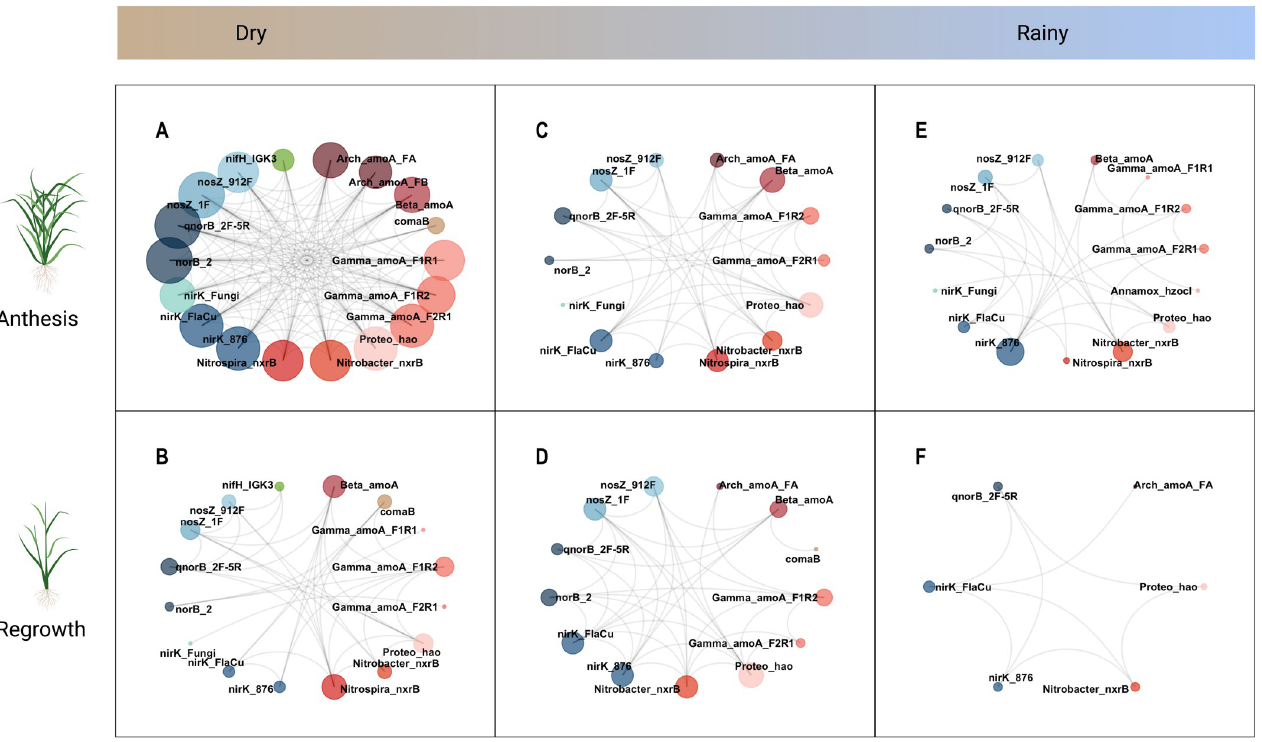
Fig 4. Non-directed intersection networks of N-cycle functional gene co-occurrences defined as a Spearman correlation of | ρ| > 0.75 and P < 0.01 (see methods). These networks display seasonally driven co-occurrences that were common to both sampling locations. Sampling timepoints occurred in the late dry season (A, B), mid rainy season (C, D), and late rainy season (E, F). Networks in the top row (A, C, E) correspond to plant growth at the anthesis stage while networks in the bottom row (B, D, E) represent early-stage regrowth at 2 weeks post-harvest. Nodes representing nitrification gene targets are shown in warm colors, while denitrification gene targets are shown in cool colors. Redundant targets for the same gene and organism were given the same color.